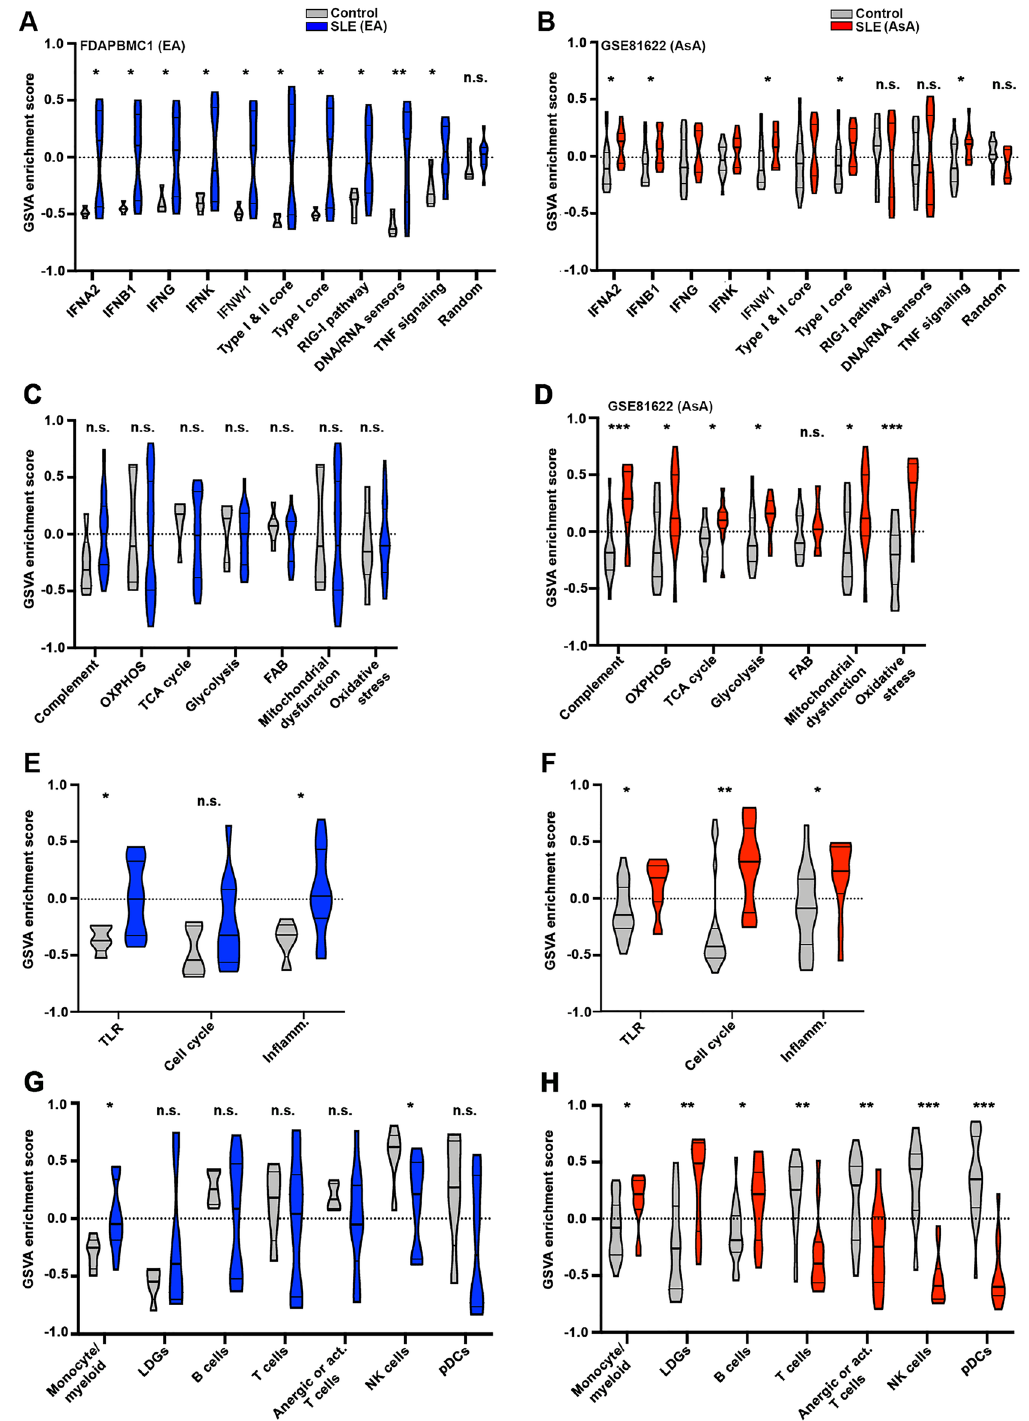
Figure 6. SNP-associated pathways inform gene signatures for GSVA analysis in patient PBMC datasets. GSVA enrichment scores were generated for PBMCs in EA and AsA SLE patients and healthy controls from FDAPBMC1 (EA-only patients and controls) and GSE81622 (AsA-only patients and controls). GSVA scores for type I and type II interferon-based gene signatures ( A , B ), metabolic gene signatures ( C , D ), cellular processes ( E , F ) and individual cell type signatures ( G , H ) are shown. Asterisks (*) indicate a p-value < 0.05 using Welch’s t-test comparing SLE to